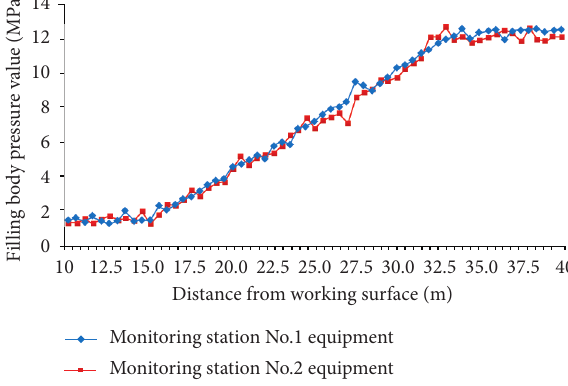
Figure 12: Measured curve of stress change of the filling body.